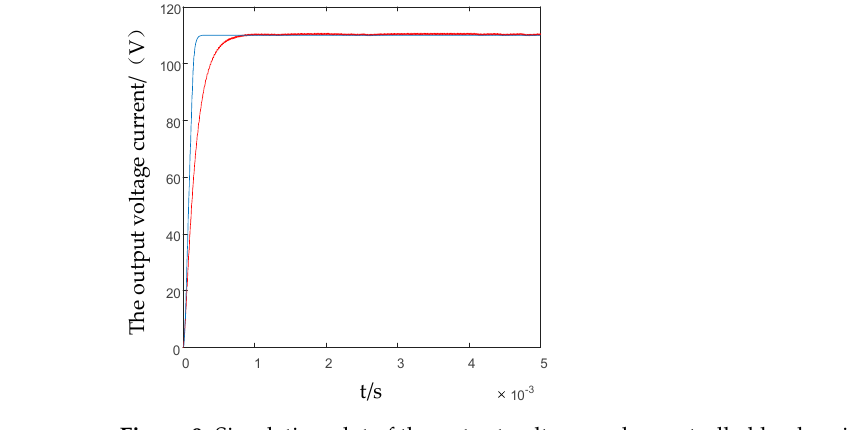
Figure 9. Simulation plot of the output voltage under controlled load variation.